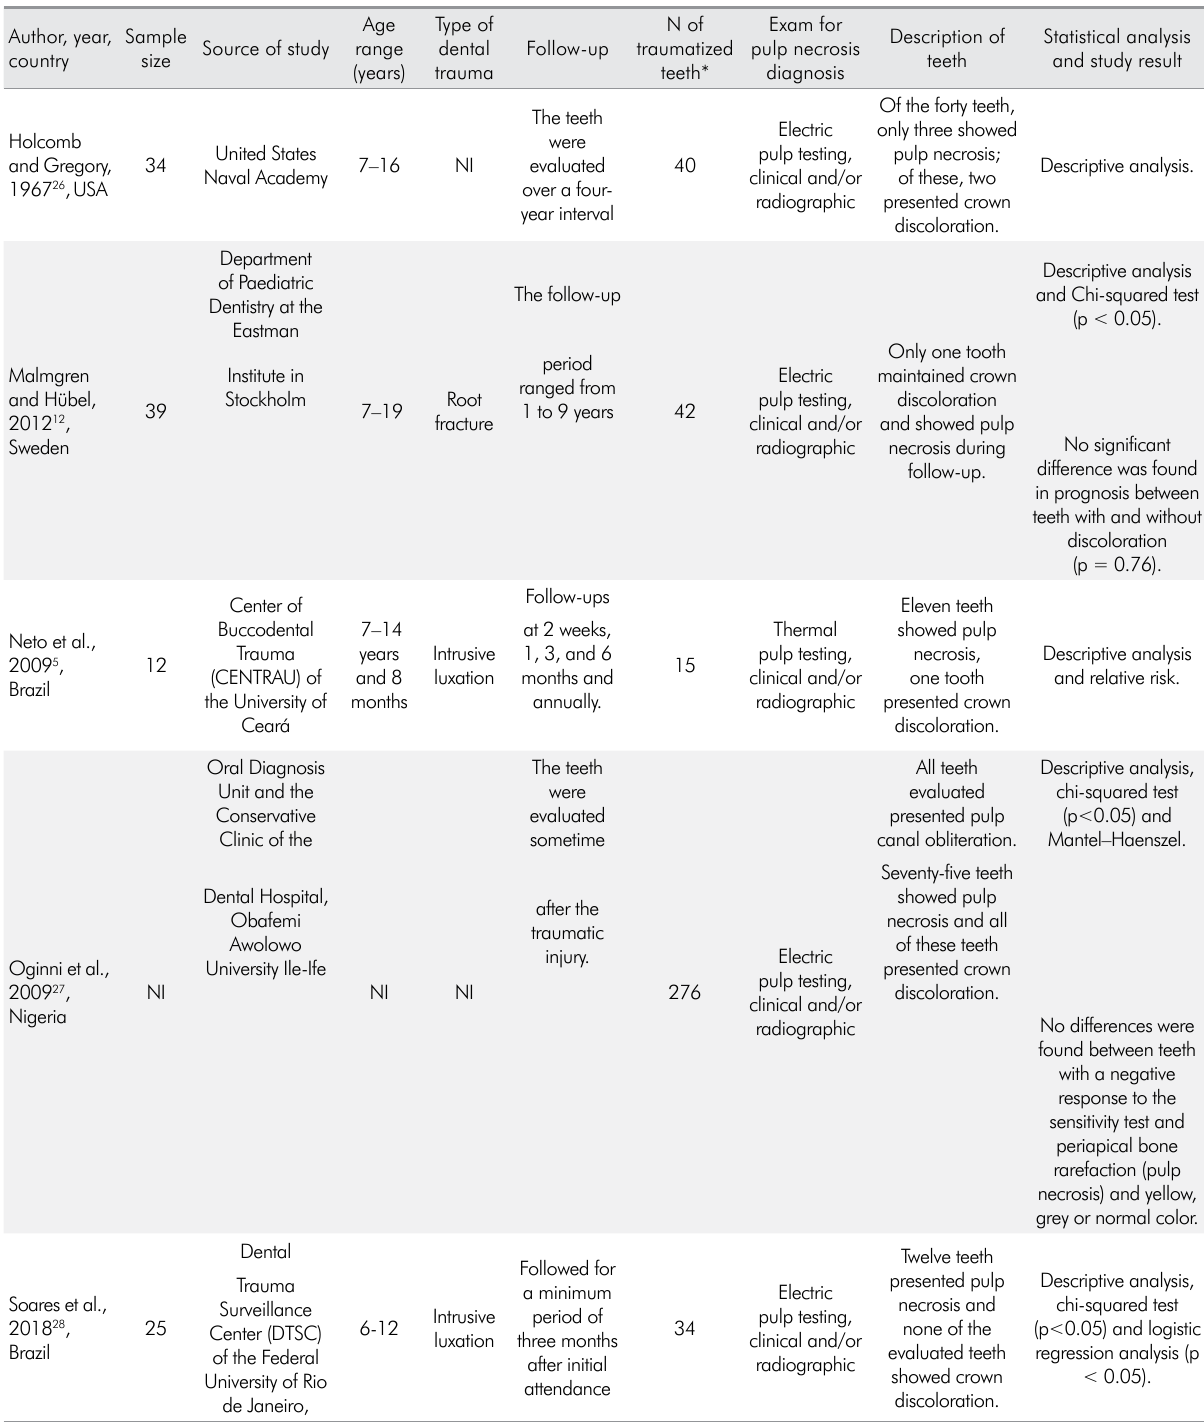
Table 3. Data extracted from the included studies. Author, year,